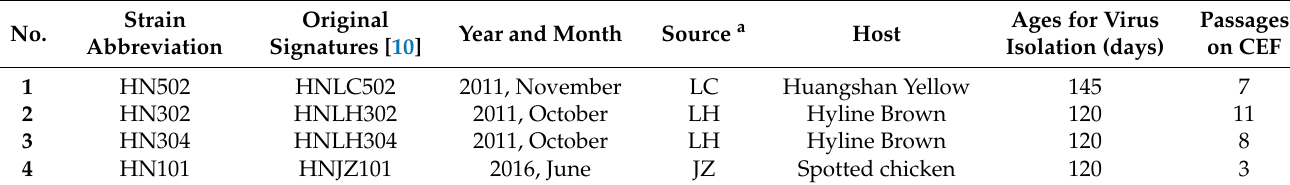
Table 1. Background information of MDV strains used in this study.